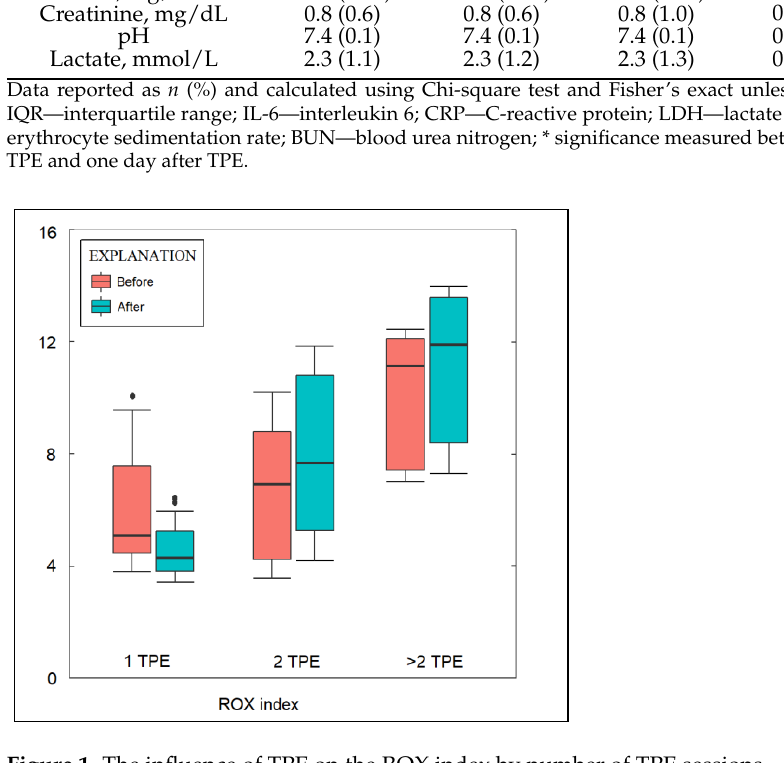
Table 3. Laboratory findings of patients with severe COVID-19 after TPE.